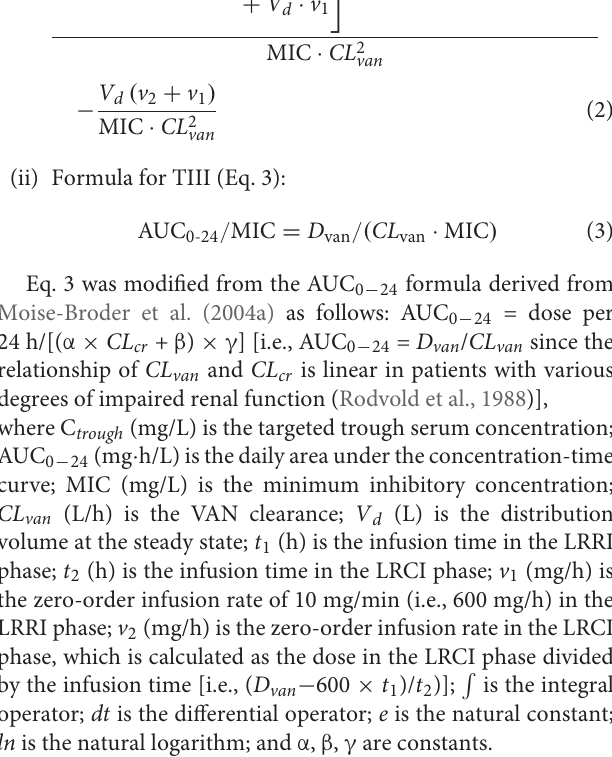
TABLE 2 | VAN for some common infections and the corresponding tissue penetration coefficient. Infections Corresponding infected